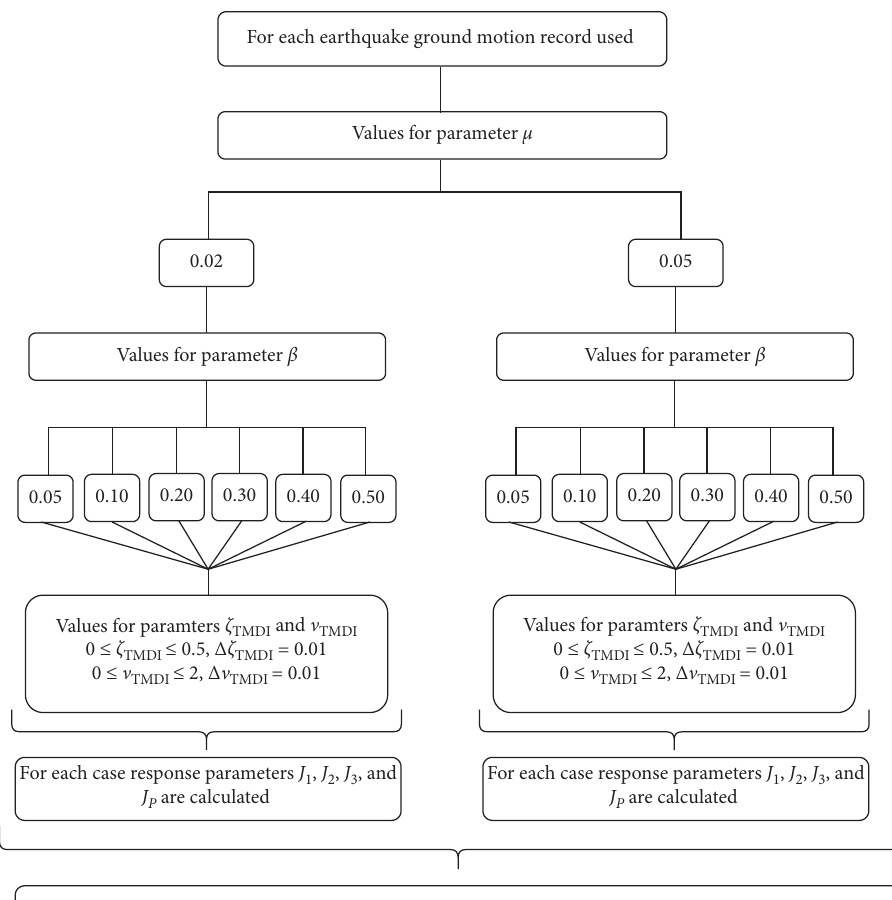
Figure 3: Logic tree diagram for TMDI device design.